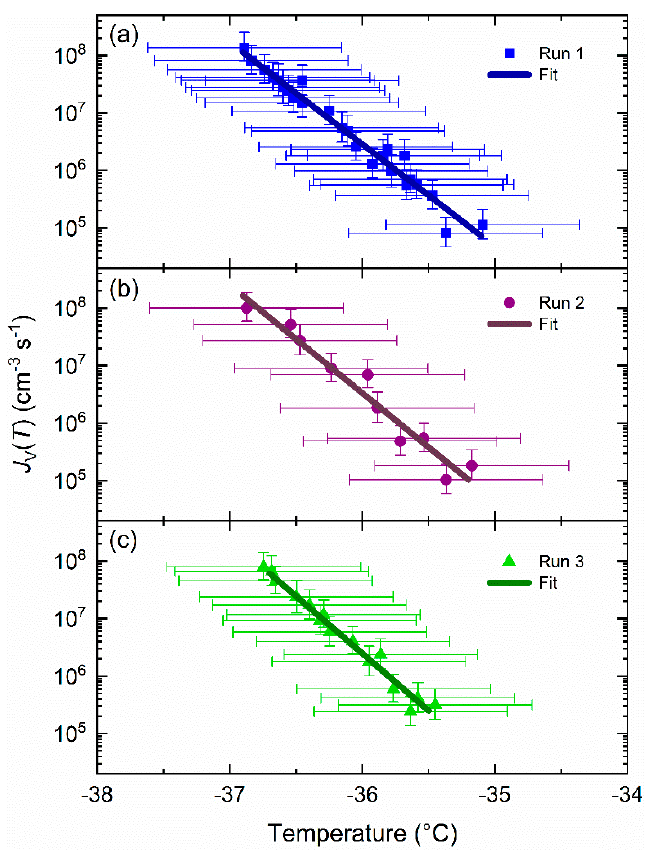
Figure A1. Plots showing the volume nucleation rate coefficients, J V ( T ), for the homogeneous freezing of purified water in each of the three microfluidic runs, together with their individual fits: ( a ) run 1; ( b ) run 2; ( c ) run 3. The experimental details of each run are provided in Table 1. The fit of J V ( T ) of each run, together with the R 2 value of each fit, is provided in Table 2. The temperature uncertainty was estimated to be ±0.7 °C.